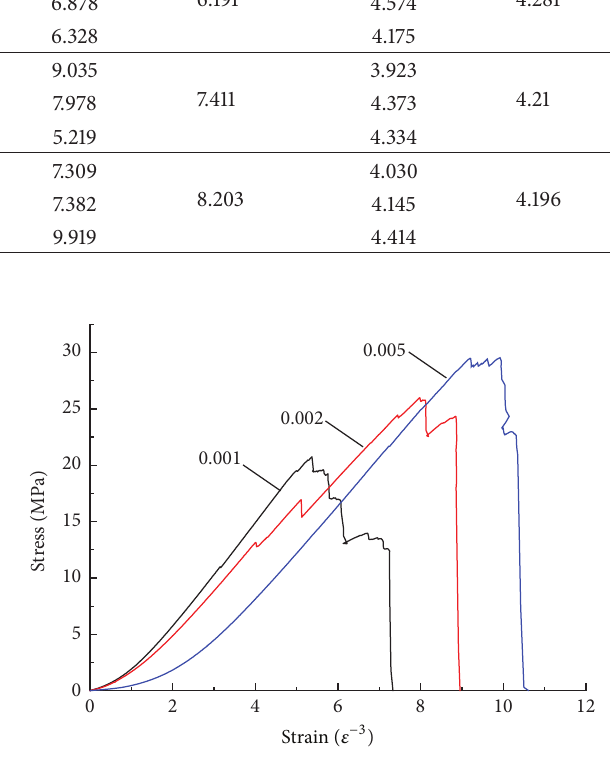
Figure 3: The overall stress-strain curves of coal samples under dif- ferent loading rates.